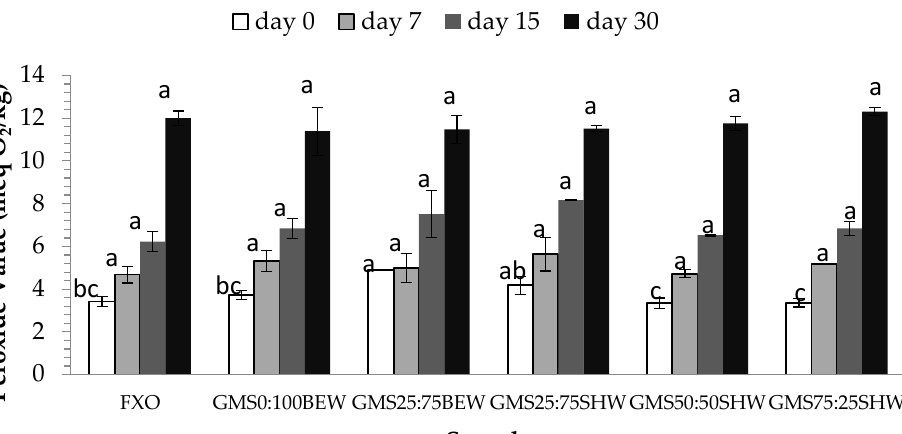
Figure 7. Peroxide value of flaxseed oil and derived oleogels after 0, 7, 15, and 30 day(s) storage at 25 °C. Different letters means statistical difference between all samples for each time.